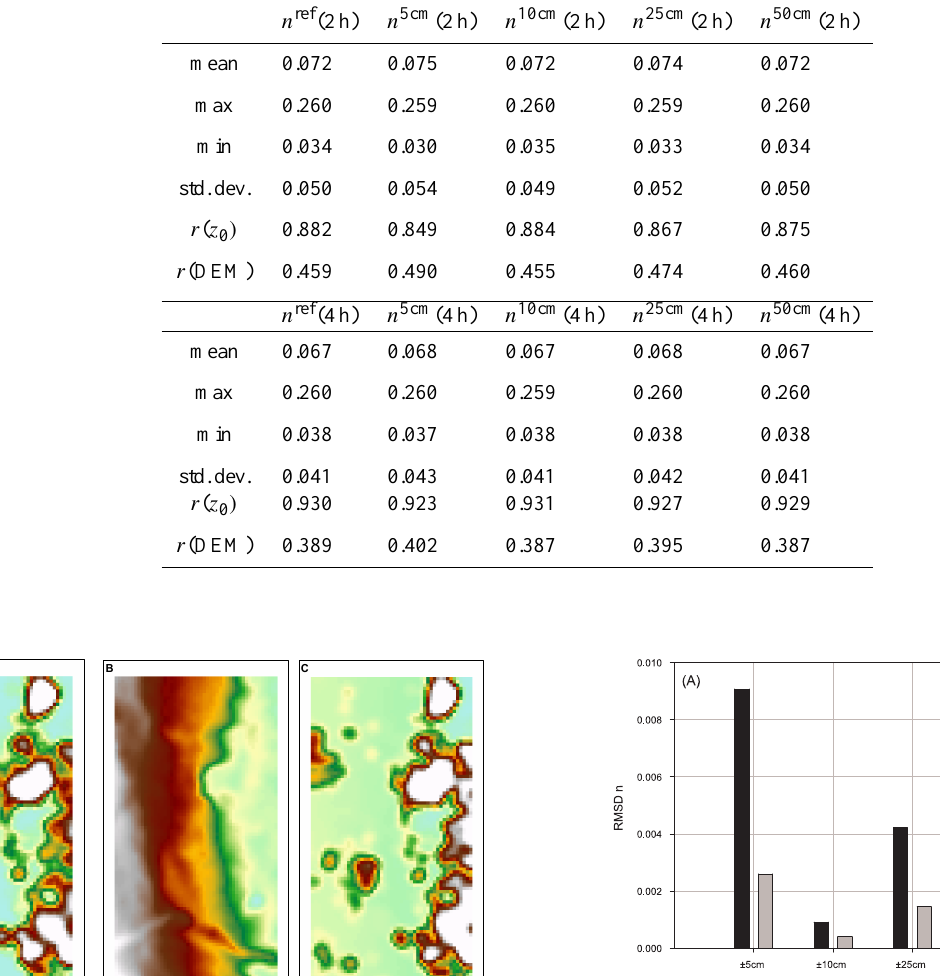
Table 5. Statistics of roughness parameter (n) due to variations in the topographic content of the DEM ( 1z ) and the roughness height ( z 0 ) of the DRM for a detailed area (Fig. 1).